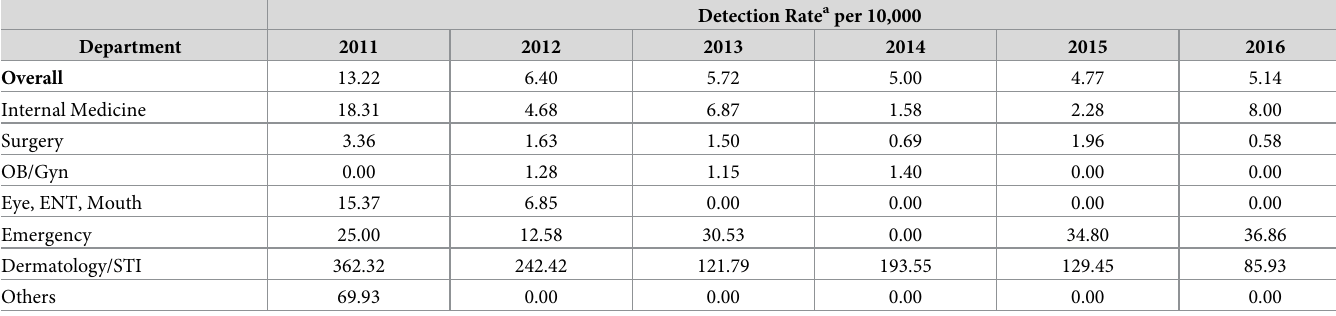
Detection Rate a per 10,000